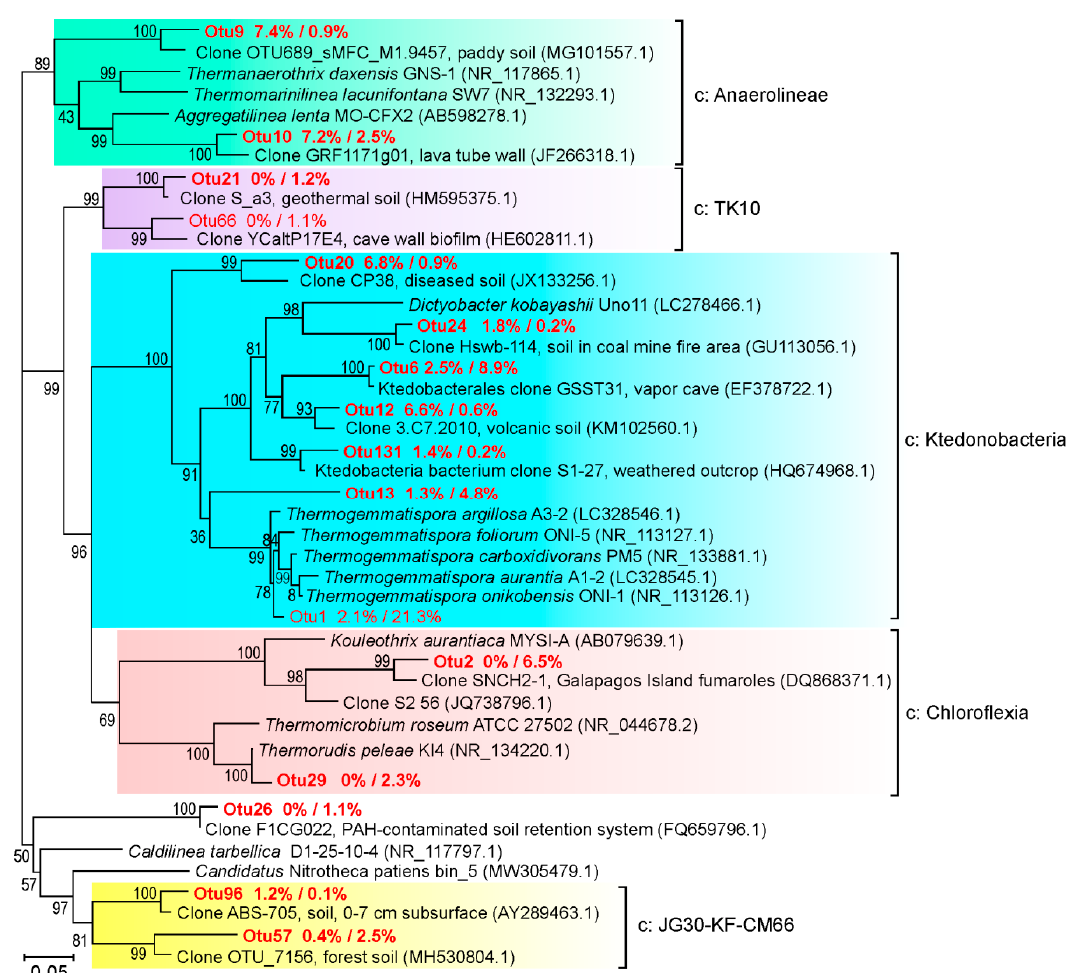
Figure 4. Maximum likelihood 16S rRNA gene phylogenetic tree of the phylum Chloroflexi. OTUs obtained in this work and assigned to the Chloroflexi are highlighted in red; only the ones accounting for >1% of reads in at least one of the two samples are shown. The shares of OTUs (in RBS38/RBS38-1) are shown after the OTU numbers. GenBank accession numbers are shown in parentheses after the clone or isolate names. The scale bar represents substitutions per nucleotide base.